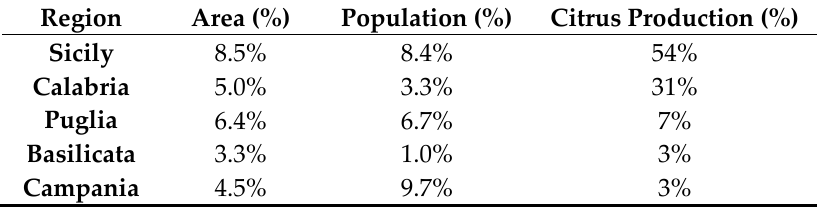
Table 1. Citrus production by regions (year